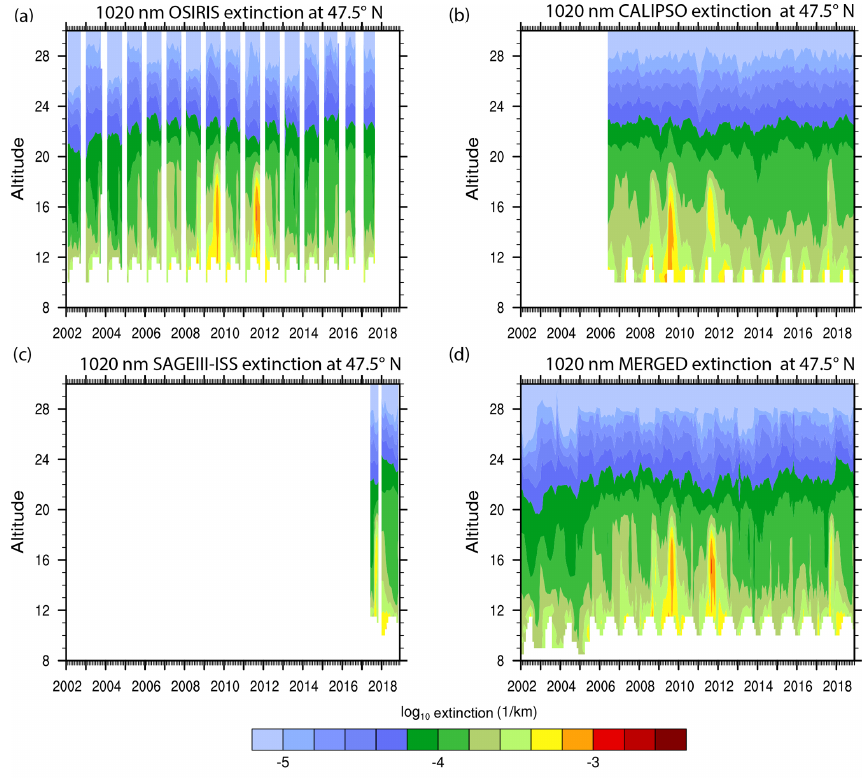
Figure 14. Altitude versus monthly time series of the 1020nm extinction coefficient at 47.5 ◦ N latitude. (a) Bias-corrected OSIRIS extinction coefficient, (b) bias-corrected CALIOP extinction coefficient, (c) cloud-cleared SAGE III/ISS extinction coefficient and (d) final merged 1020nm GloSSAC v2.0 extinction